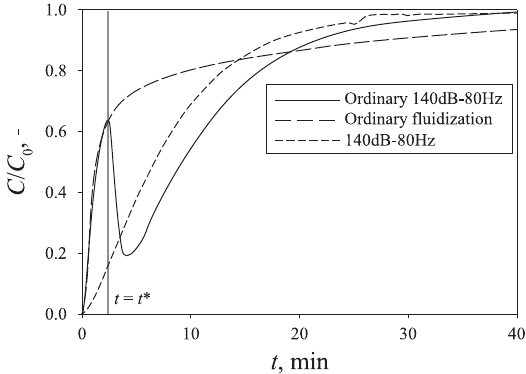
Fig. 16 Breakthrough curve obtained by switching on the sound at t = t *. u = 1.5 cm/s; C 0 = 10 %vol. Reprinted with permission from Ref. [Raganati et al.,